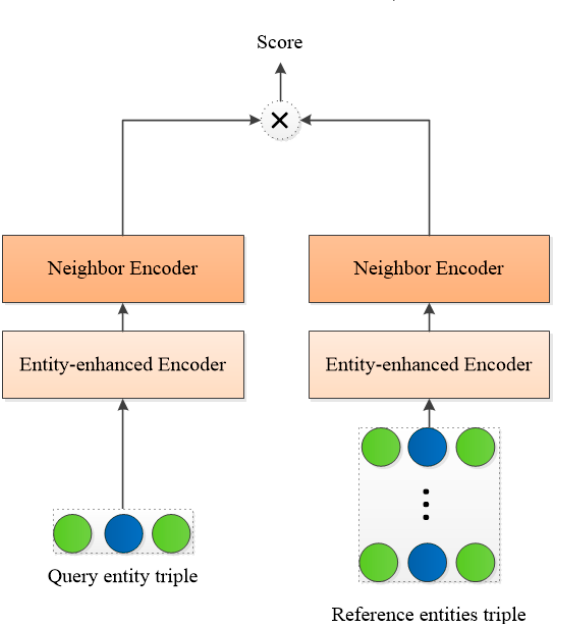
Figure 5. The schematic diagram of noise checker calculation.